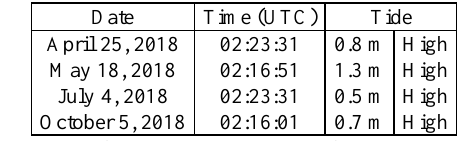
Table 5. Time of Acquisition and Tides of Sentinel-2A Datasets